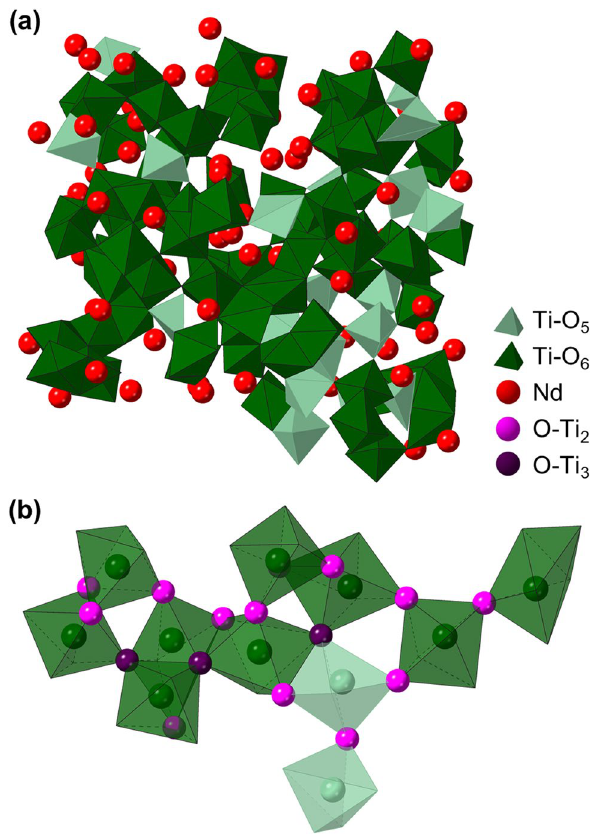
Figure 8. Selected visualizations of EPSR model. ( a ) Network structure, illustrating Ti-O 5 and Ti-O 6 polyhedra and Nd atoms. ( b ) Ti-O x polyhedra are connected via bridging oxygen (O-Ti 2 ) and triclusters (O-Ti 3 ), predominantly through corner- and edge-sharing. For clarity, nonbridging O (O-Ti 1 ) are not shown.